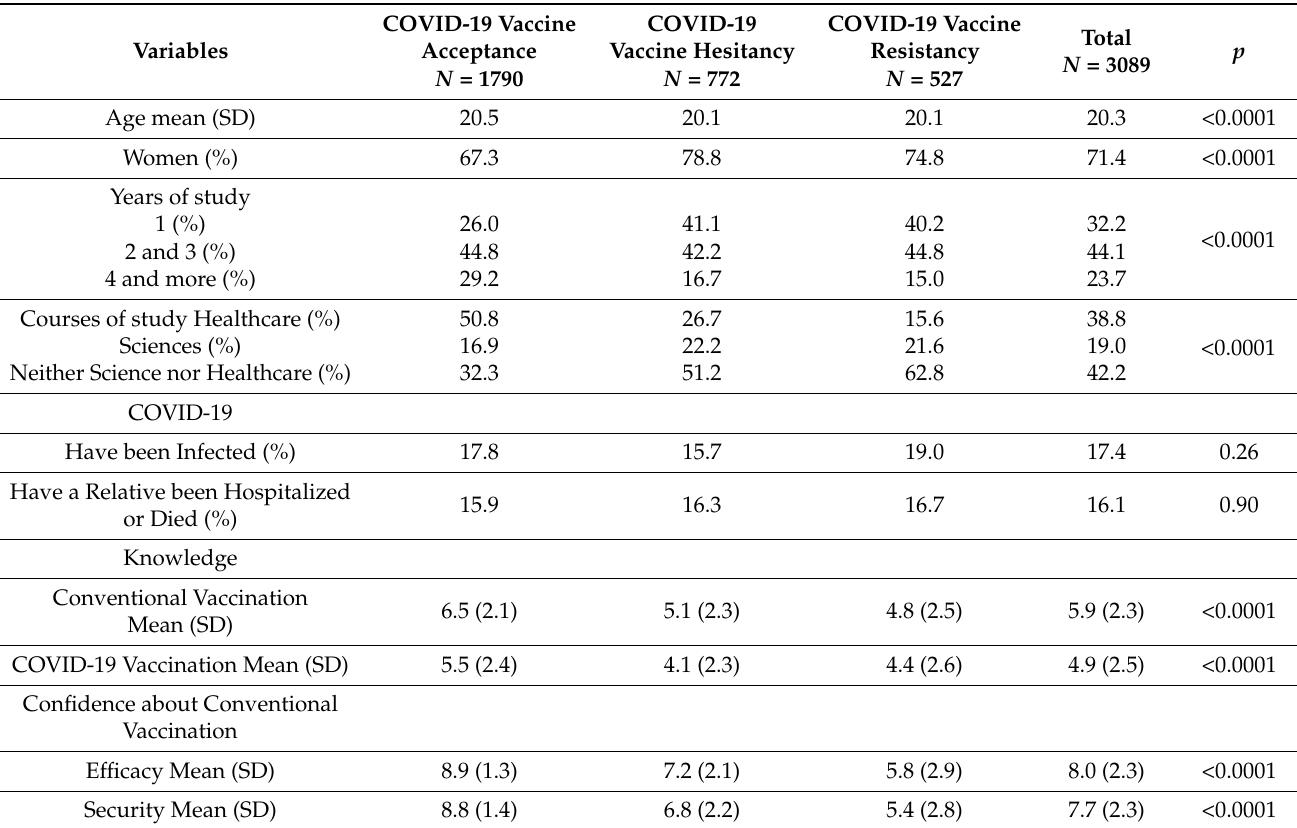
Table 2. Characteristics of the university students accord the COVID-19 vaccine decision ( N = 3089).